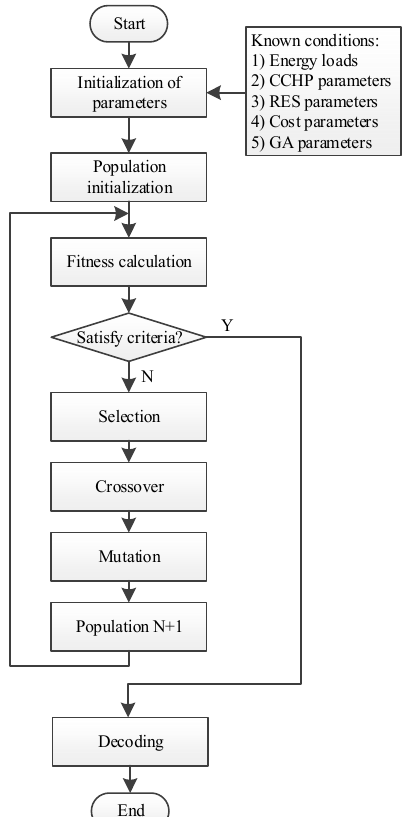
Figure 2. Flow diagram of the execution of the genetic algorithm (GA).